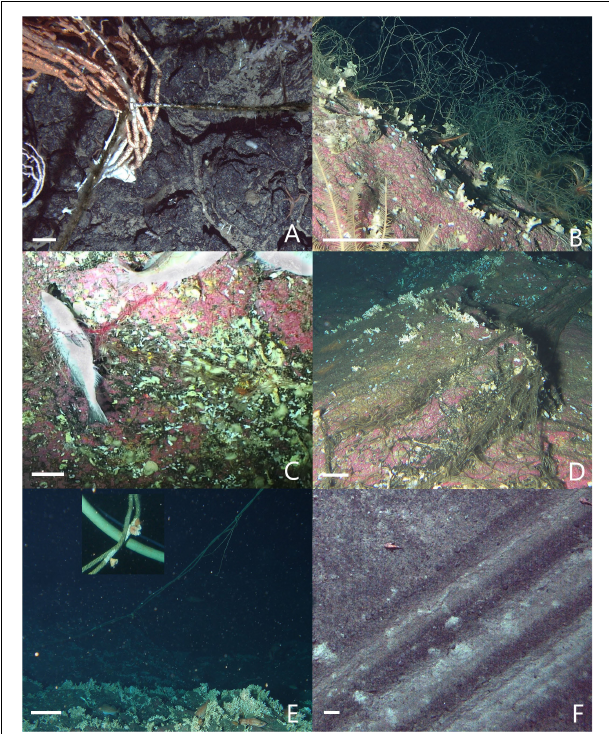
FIGURE 11 | Examples of observable impacts caused by derelict fishing gear (DFG) abandoned, lost, or otherwise discarded on Cobb Seamount, from the 2012 visual survey. (A) A fouled longline passing through a toppled and damaged large sea fan ( Keratoisis sp. A), surrounded by fragments of broken corals. (B) Monofilament net entangled in the stumps of dead and broken hydrocorals ( Stylaster spp.) and (C) the carcasses of dead rockfish ( Sebastes spp.). (D) A rope net spread across coral habitat, overlaying stumps of dead and broken corals. (E) An anchored longline groundline with dangling branch lines, attatched to floating gear, ascending into the water column. Cup coral growth on the gear is evidence it was lost years to decades ago (shown in inset image). (F) Putative drag marks in soft sediment with no associated DFG. Most images are side-on view, but the first and last images are downward-facing (from AUV). White scale bars =10